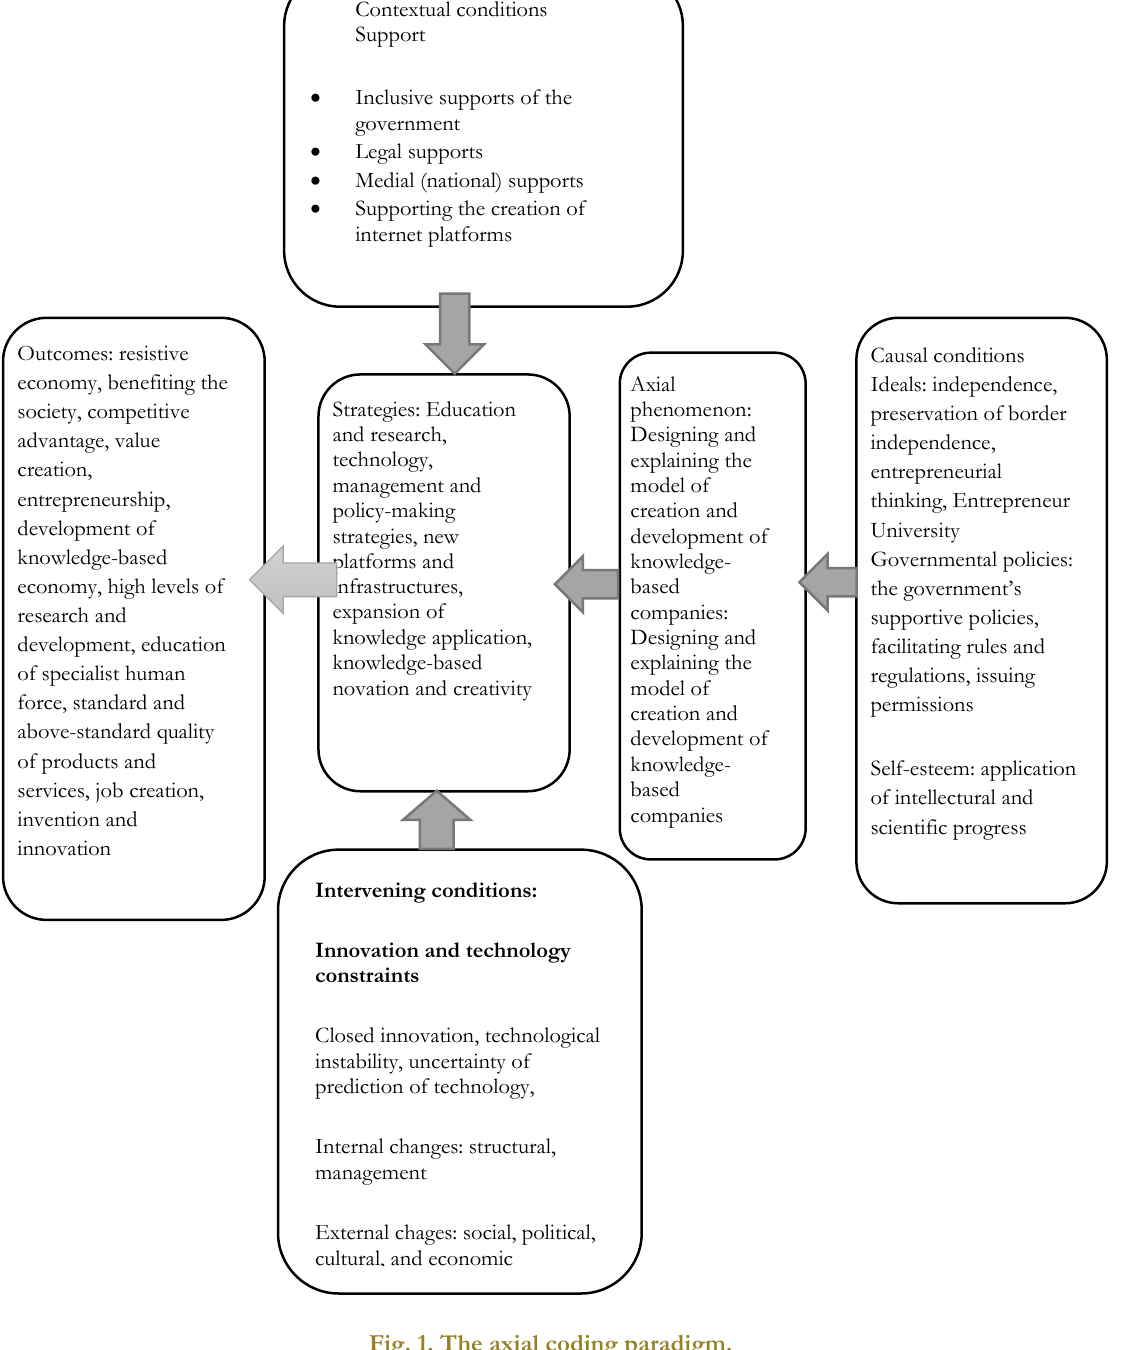
Fig. 1. The axial coding